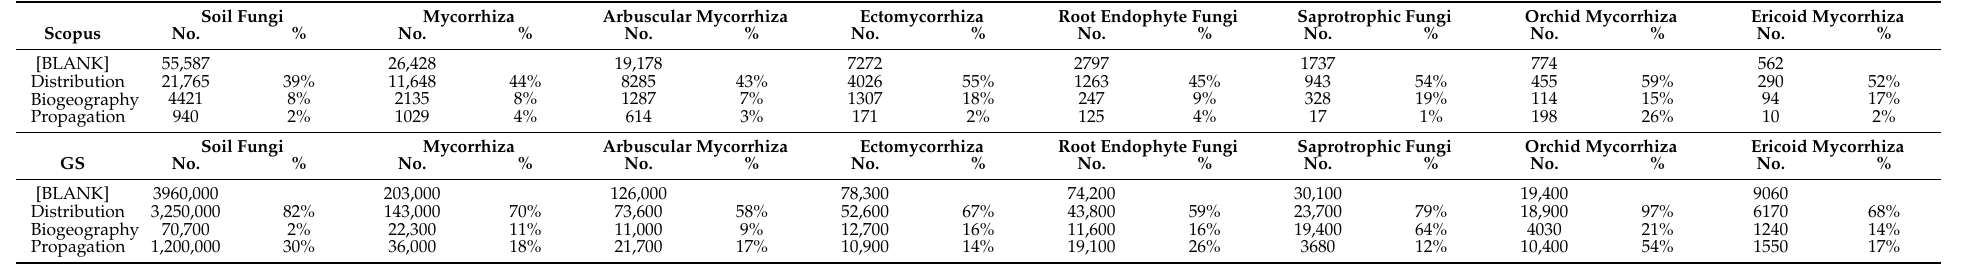
Table A1. The number of results following keyword combination searches on Scopus and Google Scholar (GS). The results are based on searches conducted on 5 December 2022. In columns, the main keywords representing groups of soil fungi are represented. The verses include secondary keywords that were used in combination with primary keywords. The ‘[BLANK]’ rows represent searches without the inclusion of secondary keywords. The ‘%’ columns indicate the number of search results featuring secondary keywords as a proportion of the number of search results where only the respective primary keyword was used. All searches were completed with the default